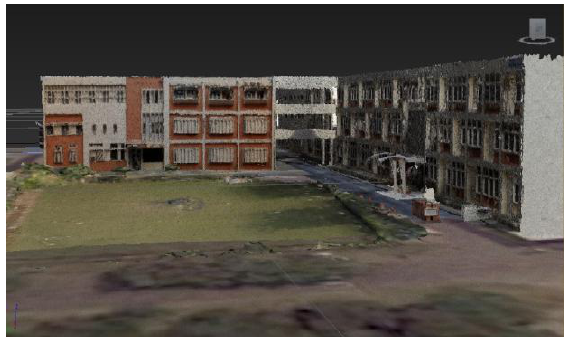
Figure 20: Another view for 3D model of civil engineering department (After rendering)